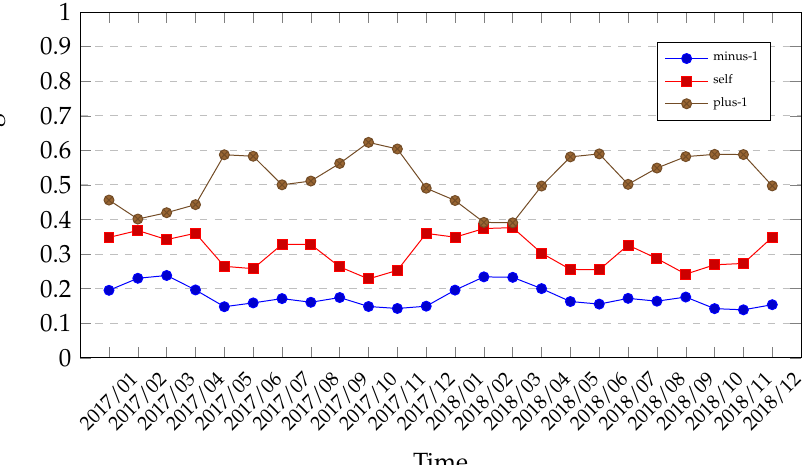
Figure 7. Attention weight on SP-CRN-1 (1,1,0) for ZH300 prediction from the average of five runs. The attention weight of minus-1, self, and plus-1 are the minus one month, the prediction month, and the plus one month of one prior periodic cycle, respectively. The scale is from 0 to 1.